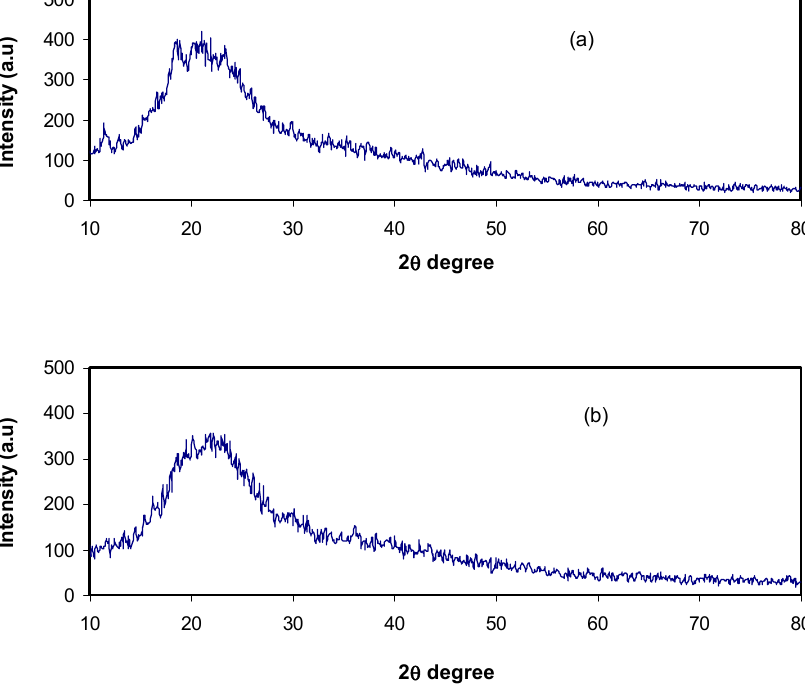
Figure 2. The XRD pattern for ( a ) CSDPB2 and ( b ) CSDPB4 blend electrolytes.